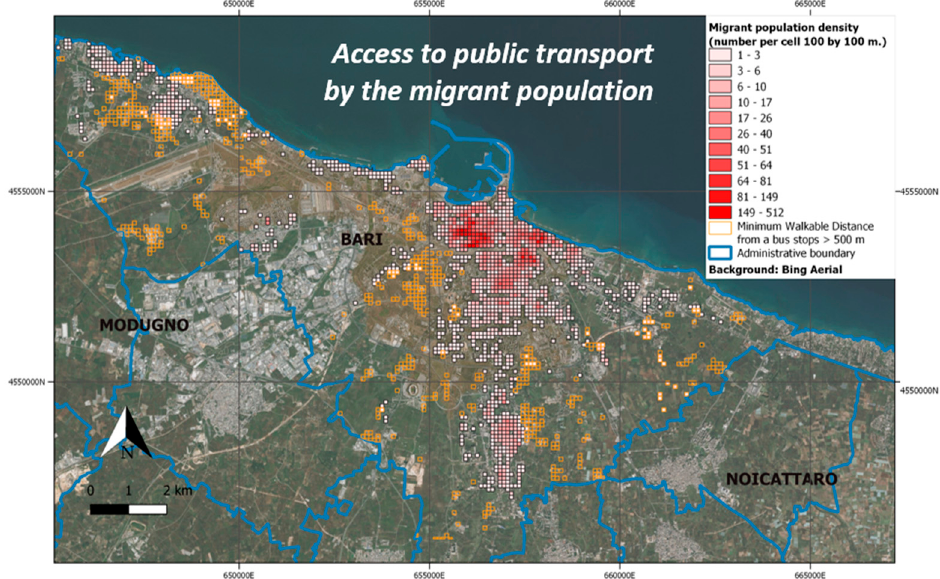
Figure 25. SDG 11.2.1 Indicator: The cells in orange, identifying people that do not have convenient access to public transport, which do not overlap cells with high values of the migrant population density.